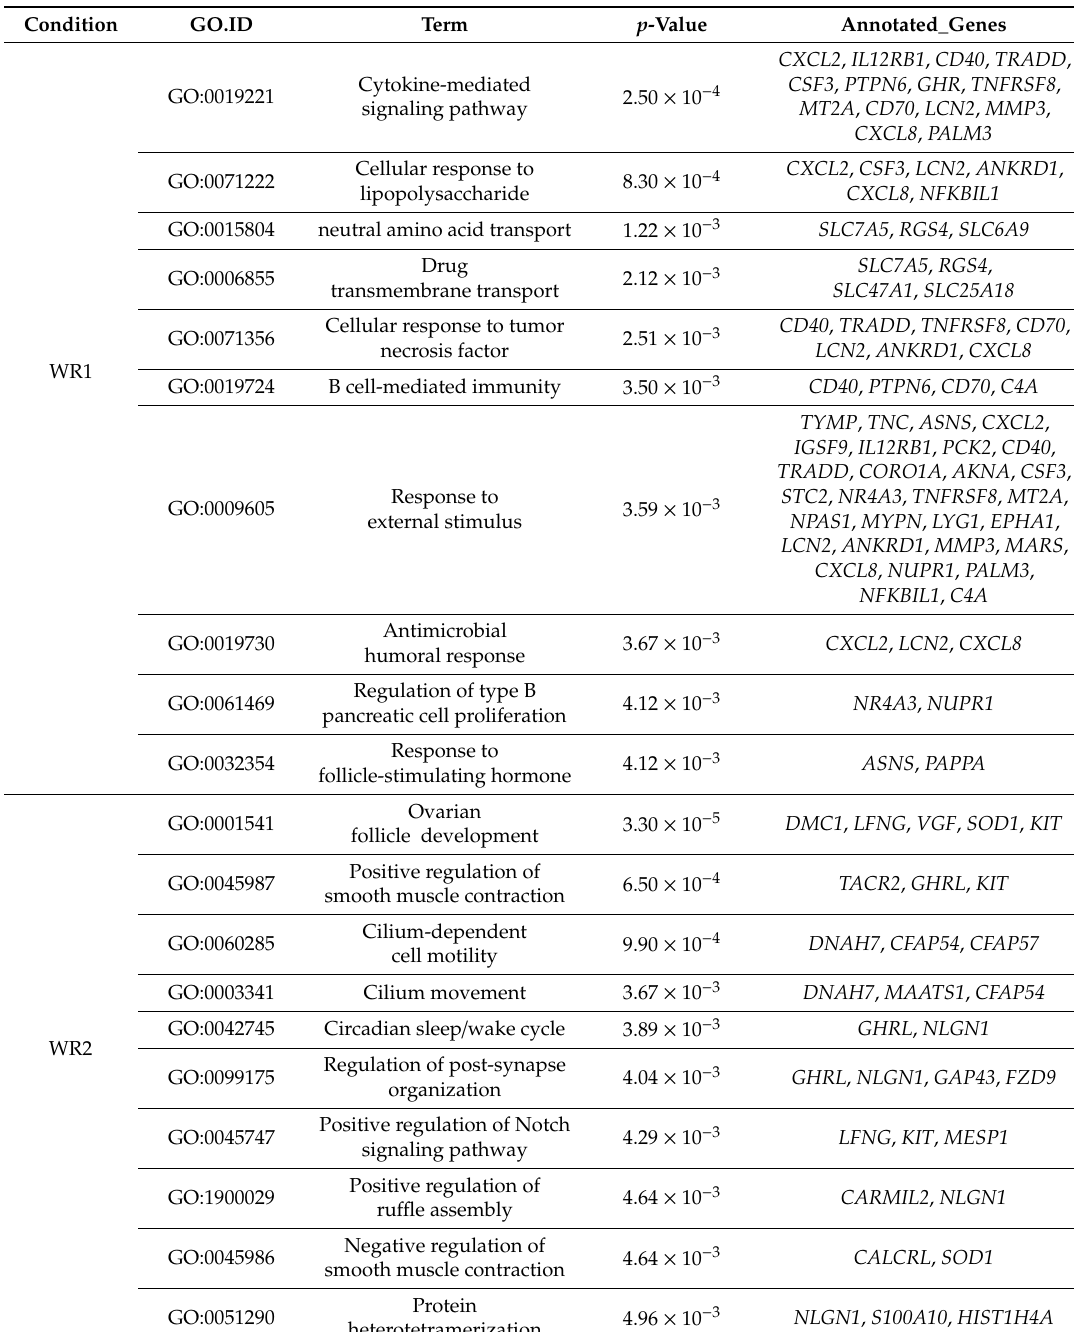
Table 1. Top10 gene ontologies (GOs) for gene enrichment analysis of DE genes with logFC > 1 unique for WR1 and WR2